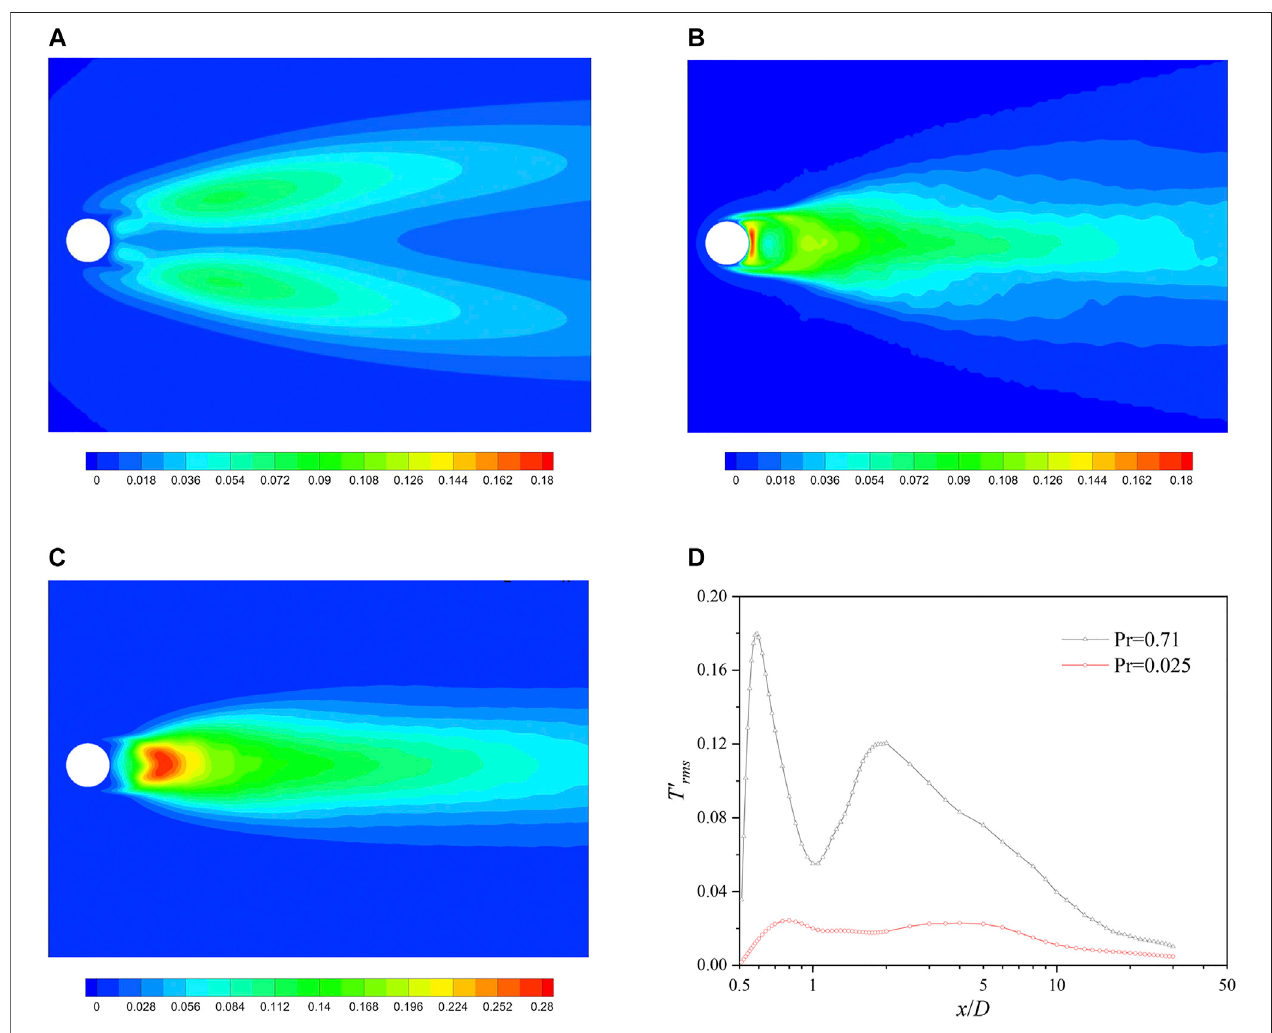
FIGURE 7 | Distributions of root mean square fi elds. (A) T ′ rms on the plane of z = 0 (LBE, Pr = 0.025); (B) T ′ rms on the plane of z = 0 (air, Pr = 0.71); (C) k on the plane of z = 0; (D) variation of T ′ rms along the wake axis.